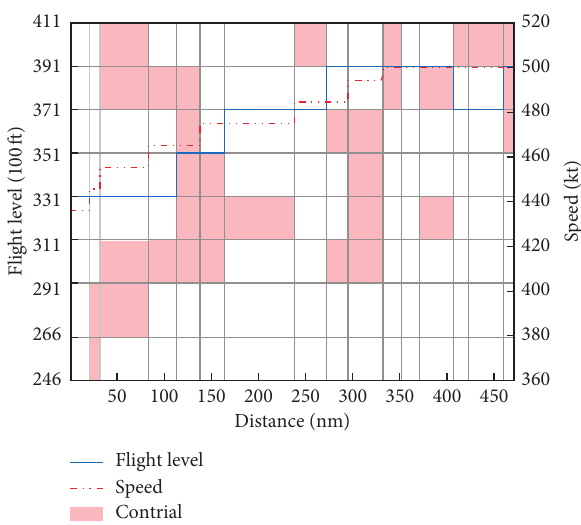
Figure 3: The optimized cruise strategy for flight CHH7605 on December 1, 2020.